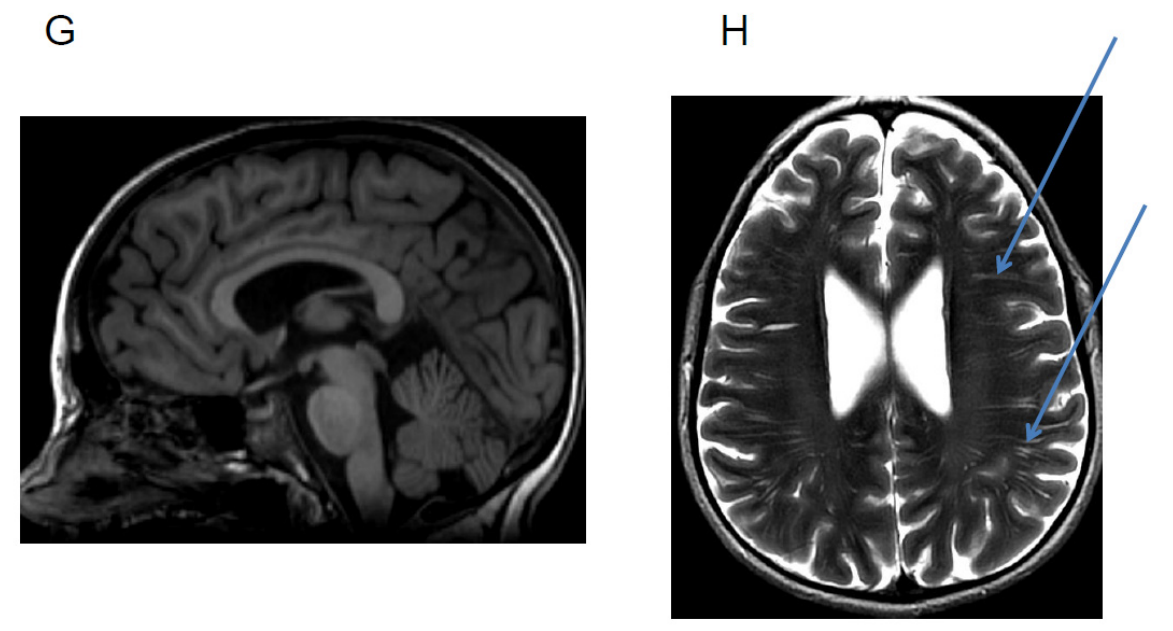
Figure 2. Axial FLAIR sequences. Examples of brain MRI anatomical images of cystinosis patients showing ( A ) an isolated ventricular dilatation (red arrow), ( B ) in another patient, cortical atrophy (green arrow) and diffuse white matter anomalies (blue arrow) associated with ventricular dilatation, ( C – F ) diffuse subcortical white matter hyperintensities, and ( G , H ) Wirshow or perivascular space enlargement (blue arrow)(images from N. Boddaert, Necker